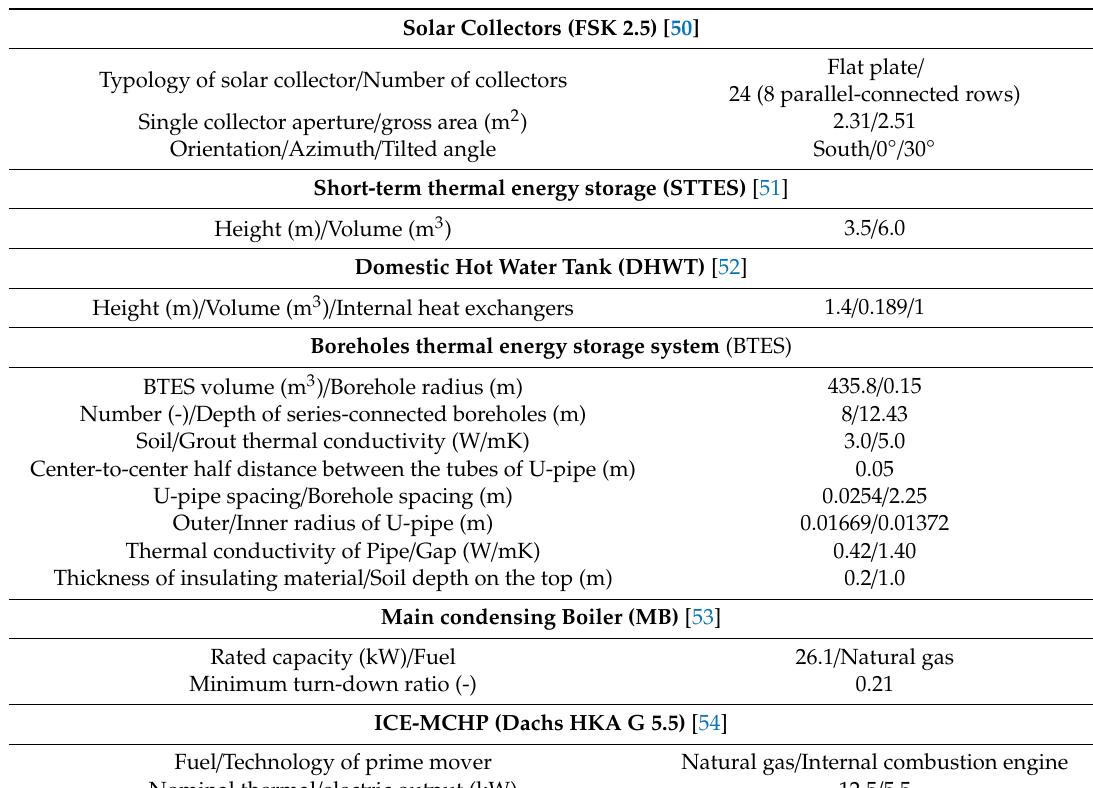
Table 4. Main characteristics of plant